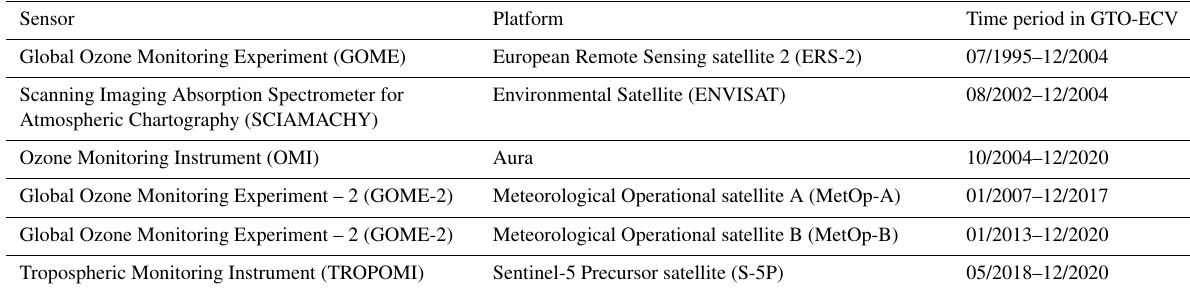
Table 1. Overview of satellite sensors incorporated in